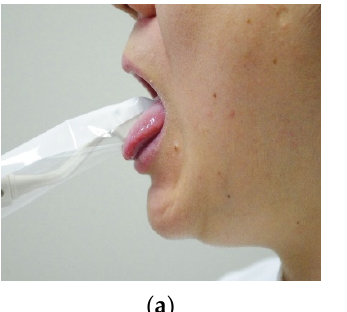
Figure 2. Measurement of agar moisture.